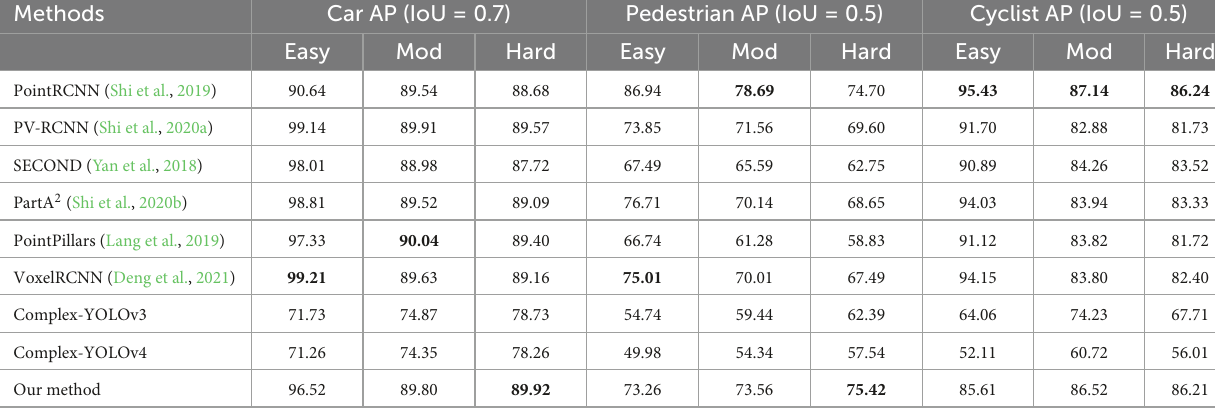
TABLE 4 Experimental results of comparison experiments with other algorithms. Methods